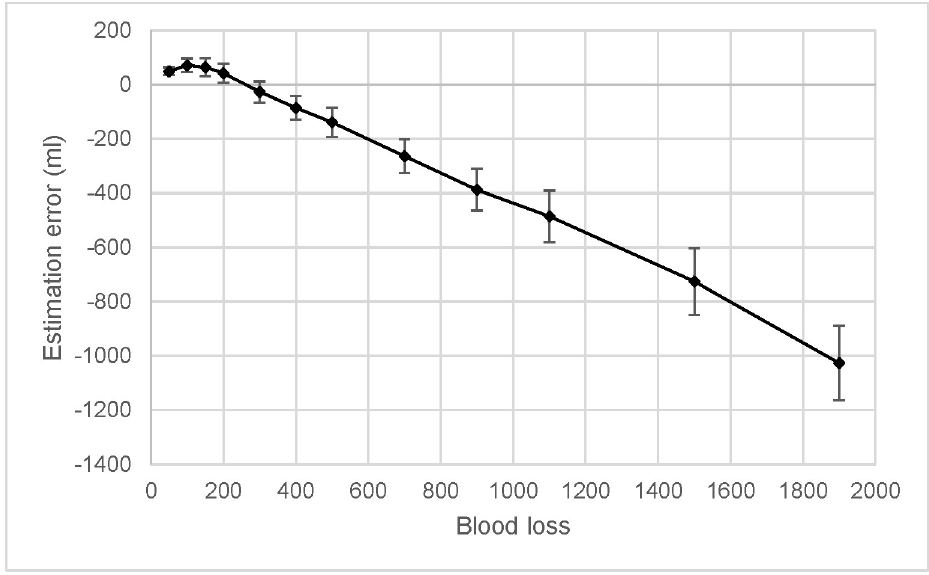
Fig 3. Estimation error over actual blood loss. The black line indicates the mean error, with 95% CIs as errors bars.